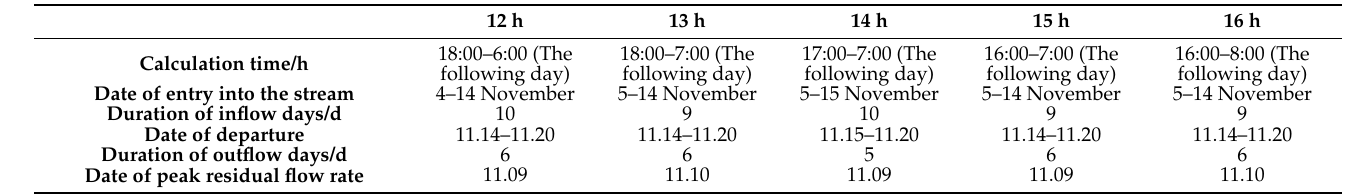
Figure 9. Migration path and monitor points arrangement. Table 2. Variations of inflow periods for various cases (dates are recorded in the lunar